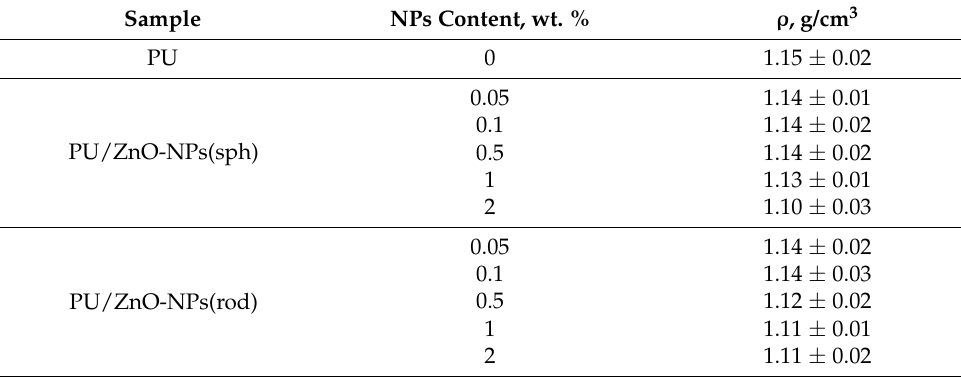
Table 4. The density of the polymeric membranes.